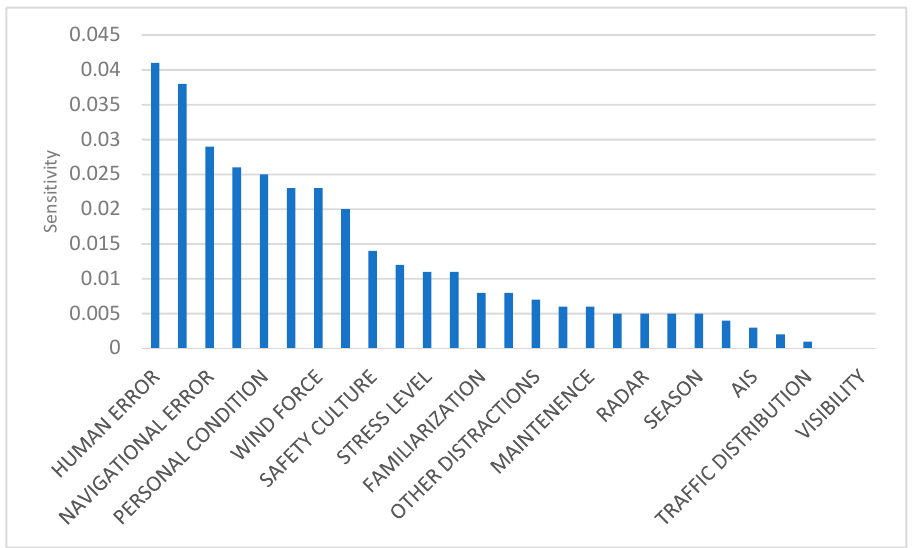
Figure 7. Sensitivity of “grounding” to causal variables of the model (w/o “navigation in shallow waters” and “special caution area”).